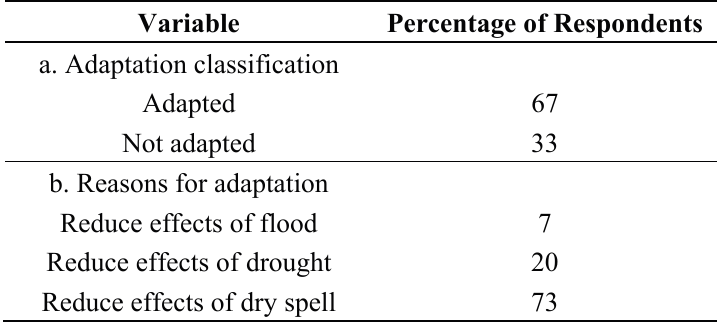
Table 3. Proportion of farmers by adaptation classification and reasons for adaptation in the Lawra district of Ghana ( Number of respondents =